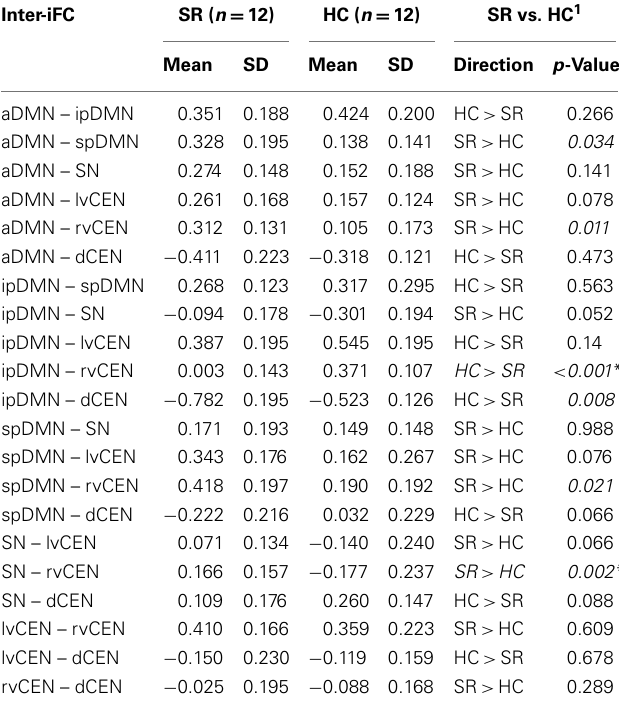
Table 5 | Inter-network intrinsic functional connectivity in patients with schizophrenia in state of remission and healthy